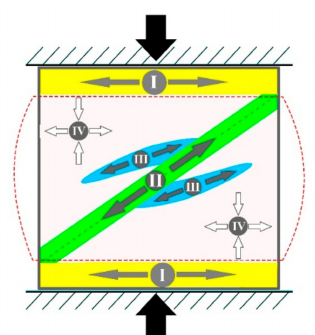
Figure 8. Schematic representation of specific zones distinguished in the longitudinal section of tested cylindrical specimen (Roman number denote a given zone; the arrows indicate the direction of compressive